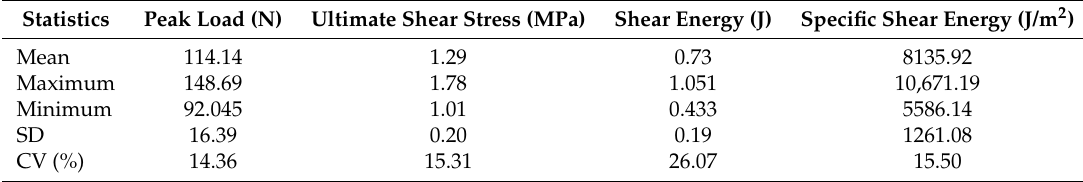
Table 4. Results for 20 aubergine peduncles tested with the notched blade.